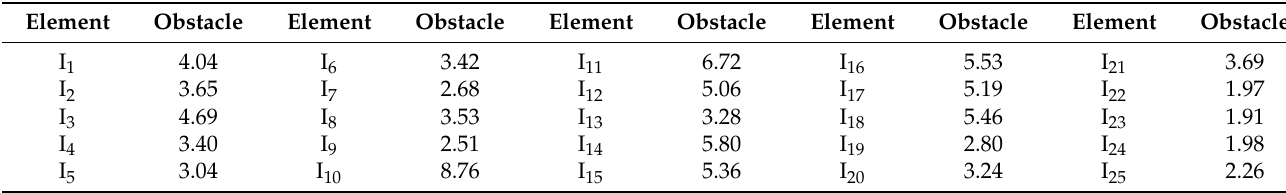
Table 5. Subsystem level barriers to AUCWR in 2018